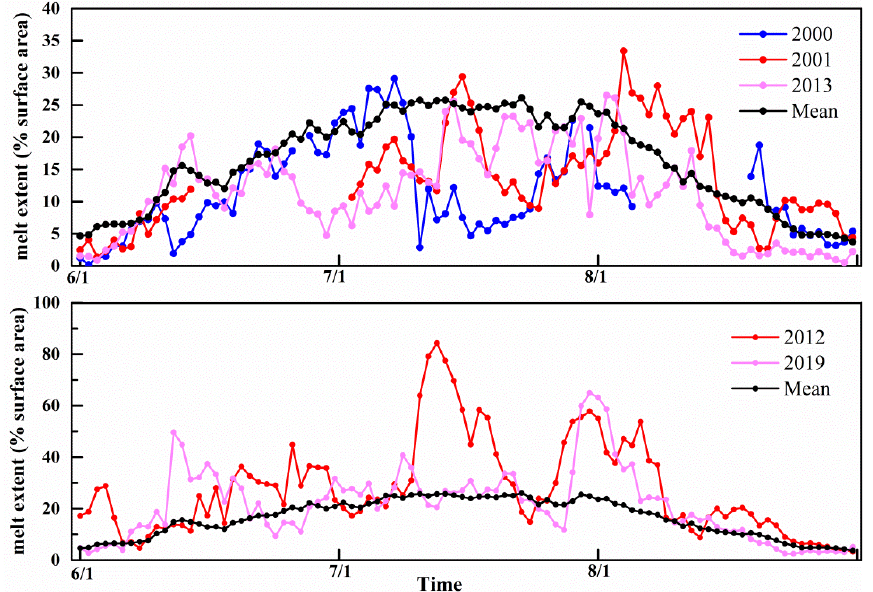
Figure 5. The GrIS daily and mean melt extent for summer (here, 1 June – 31 August). (Data for 2000 and 2001 are partly missing. Percentage is calculated with respect to total number of pixels with LST observations for each date. The mean melting extent is derived from the summer 2000 – 2020 daily melting extent). melting